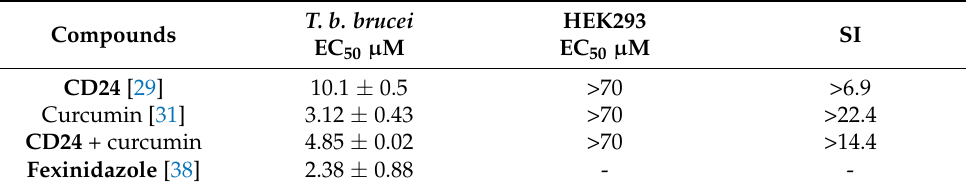
Table 3. Activity against T. brucei brucei and HEK293 cells and selectivity index (SI) of CD24 and curcumin alone and of the combination CD24 + curcumin.